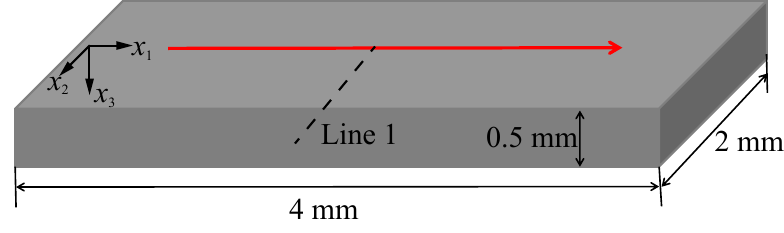
Figure 9. A single laser scan is applied on a finite